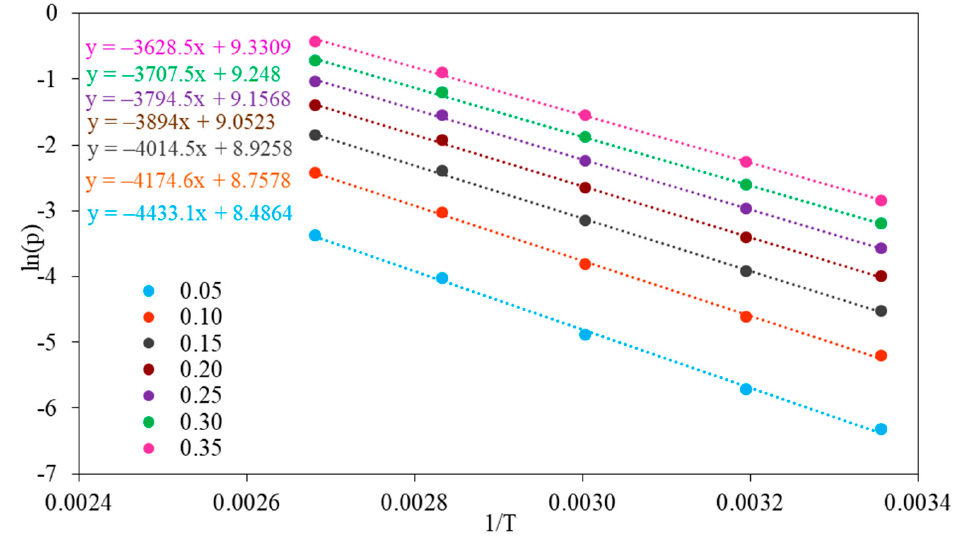
Figure 12. Plots of ln( p ) vs. 1/T for surface coverage from 0.05 to 0.35 for Li 0.61 Na 0.39 X.